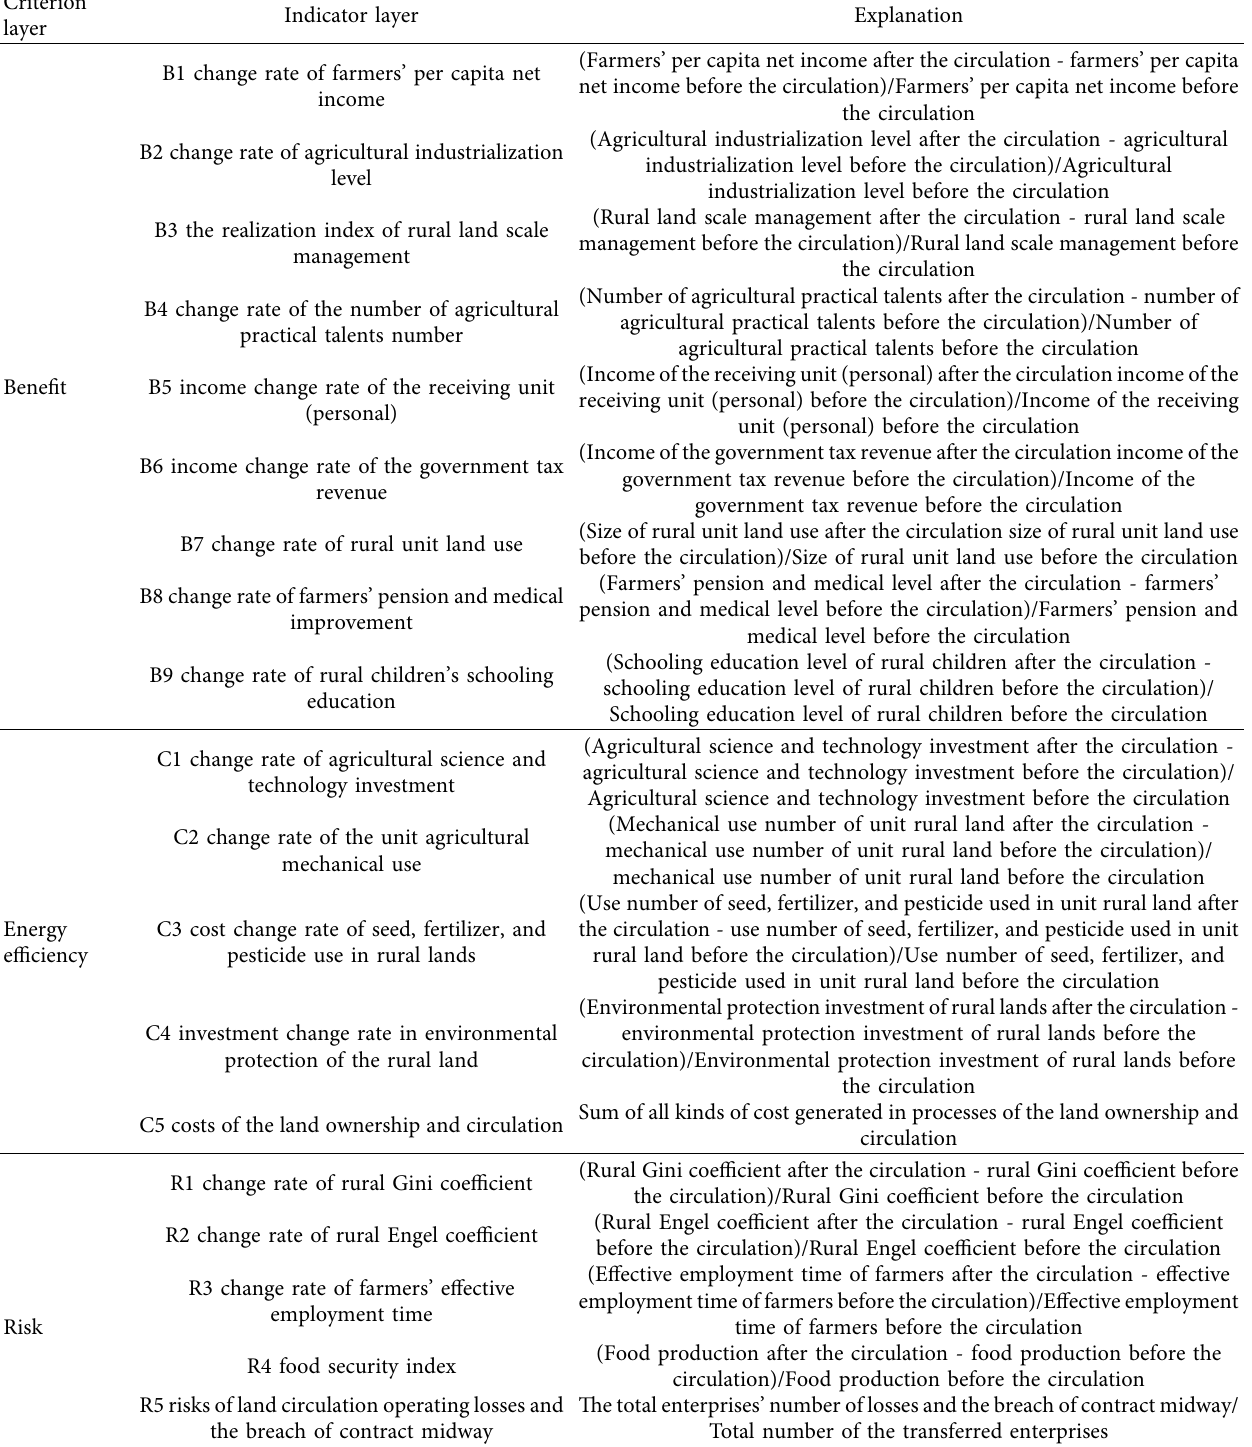
Table 1: Index system and its explanation of performance evaluation of the rural land circulation mode.